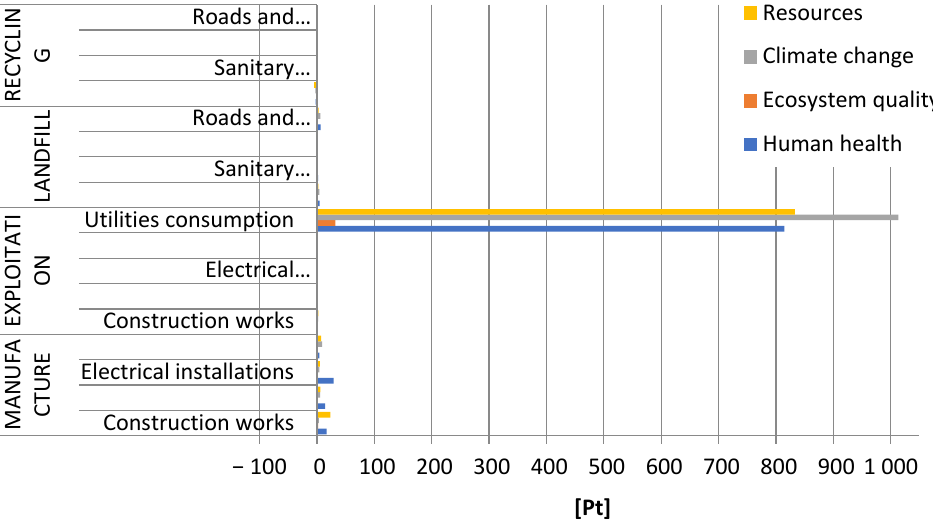
Figure 18. The results of grouping and weighing the environmental consequences occurring at individual stages of the life cycle of the research object by areas of influence.